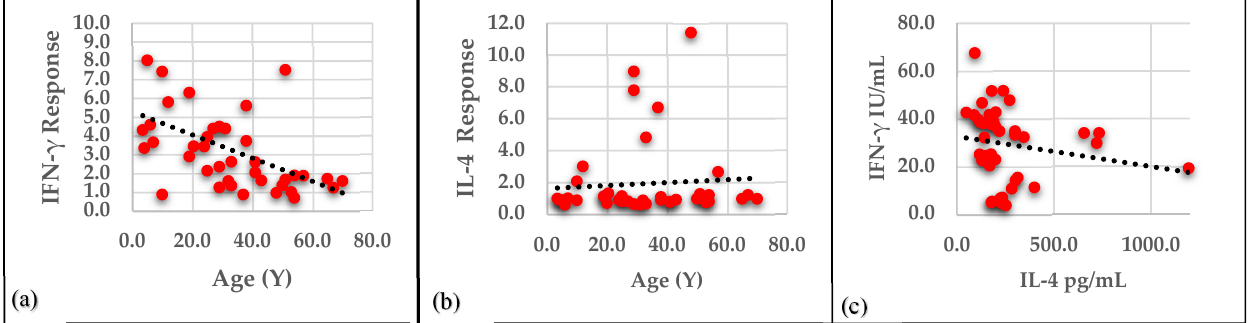
Figure 3. ( a ) Correlation between IFN- γ response and age in patient group. ( b ) Correlation between IL-4 response and age in patient group. ( c ) Correlation between IFN- γ (IU/mL) and IL-4 (pg/mL) level in stimulated cultures in the patient group ( n = 40).